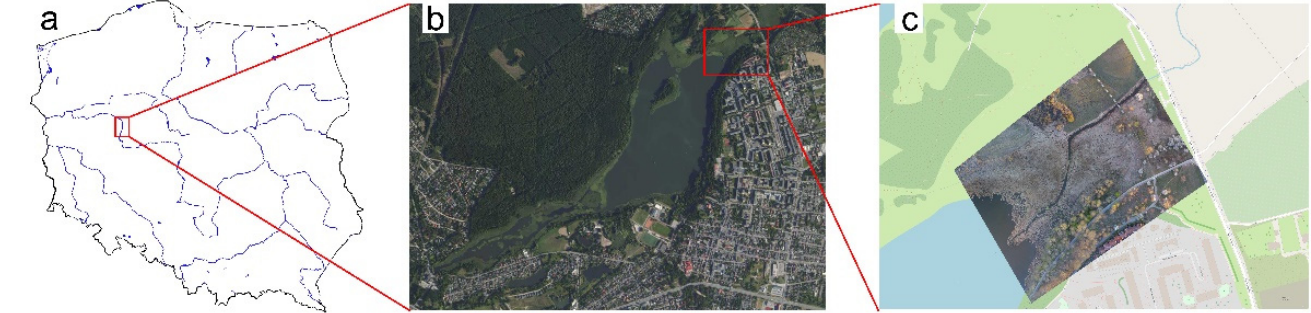
Figure 1. Location of the research area in Poland ( a ), Lake Swarz ę dzkie ( b ), thermal imagery area ( c ).